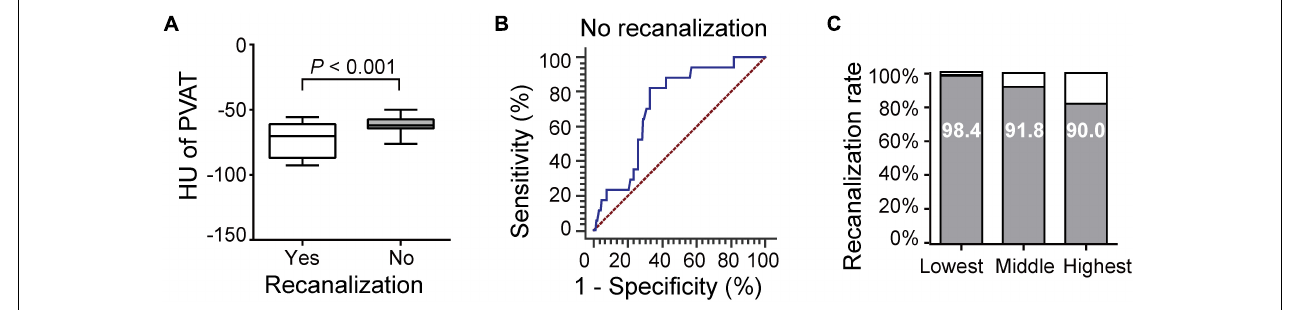
FIGURE 2 | Association of carotid artery PVAT density with recanalization. (A) Comparison of patients with and without recanalization. (B) ROC analysis was performed to assess the accuracy for predicting unsuccessful recanalization. (C) Successful recanalization rates based on the PVAT classification. HU, Hounsfield units, PVAT, Perivascular adipose